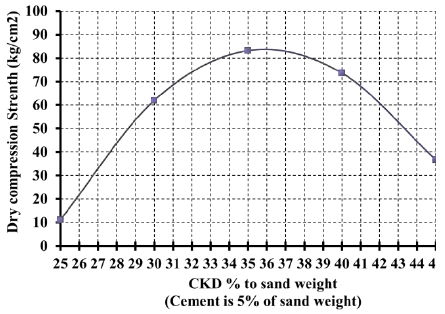
Figure 23. Dry compressive strength.